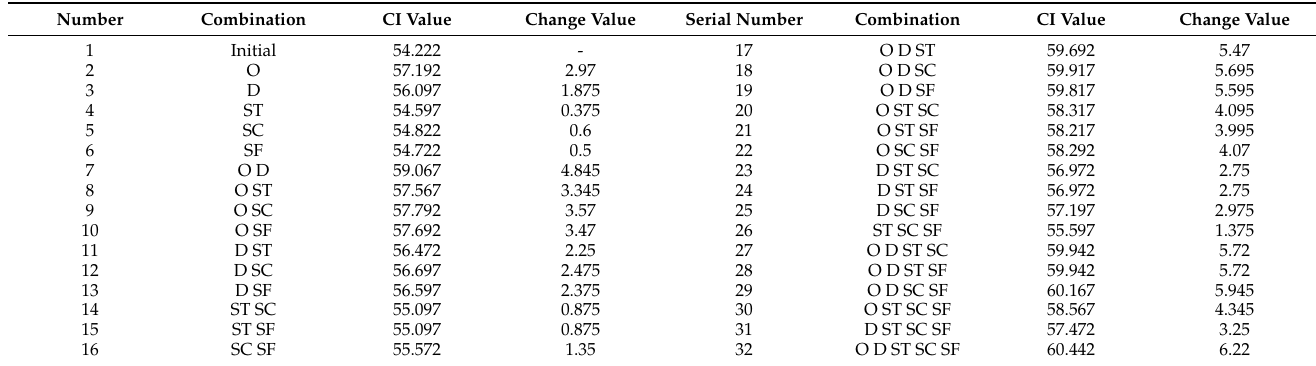
Table 14. Sensitivity analysis of different combinations of risk